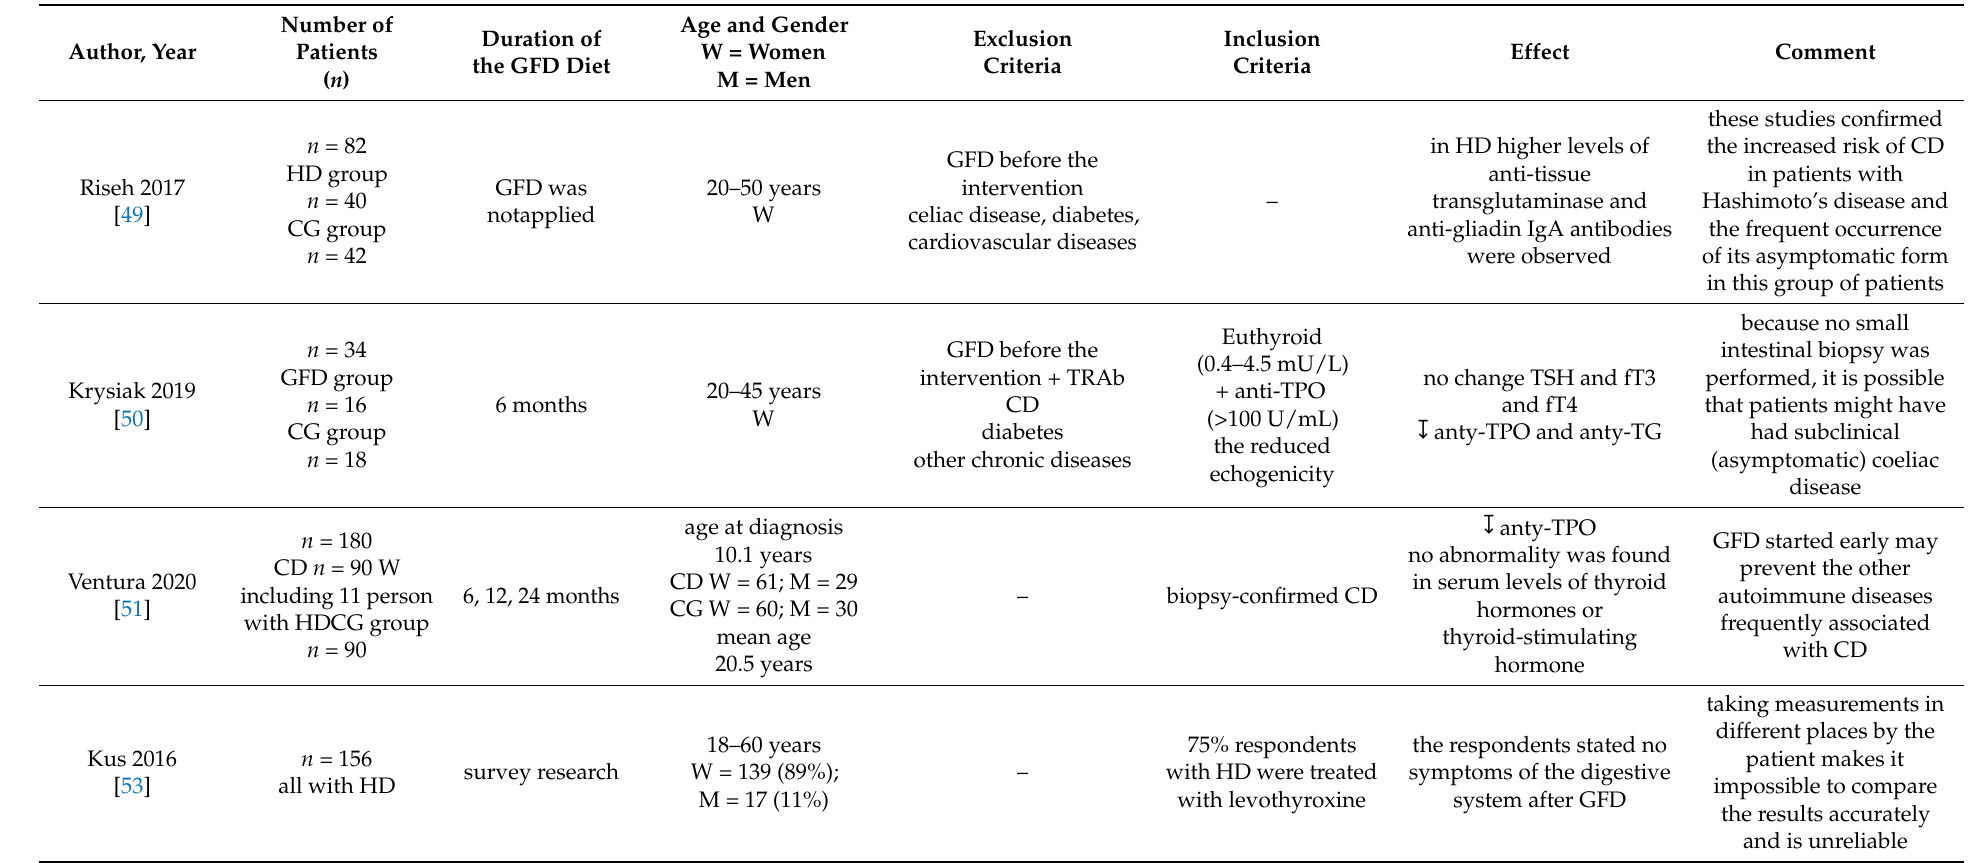
Table 155: fdsymbol Negated